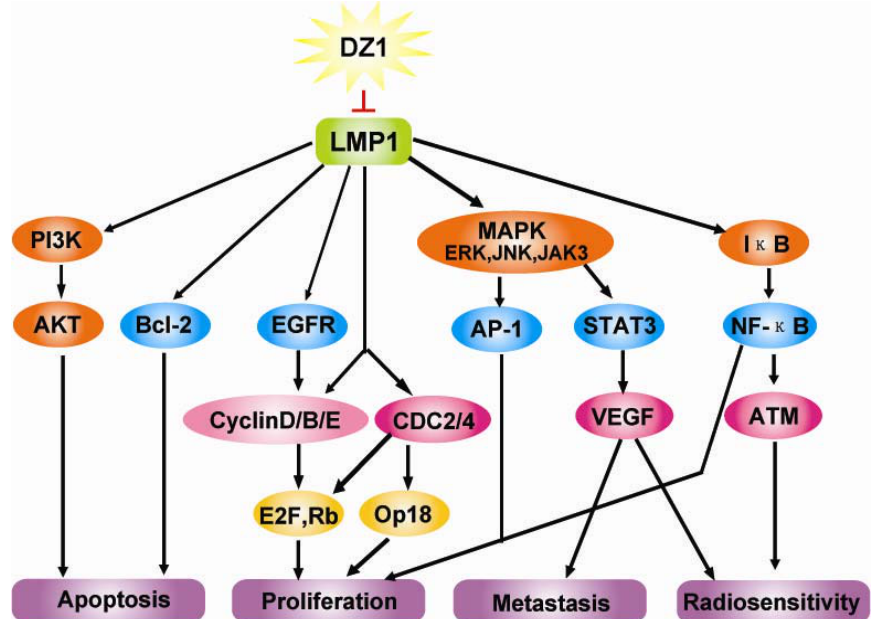
Figure 8. Impact of Dz1 on signal pathways and associated cell functions in NPC